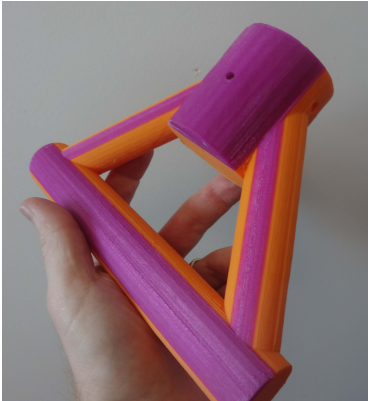
Figure 3. A 3-D printable customizable shovel handle in which the color of the filament had been switched during the print for cosmetic reasons.